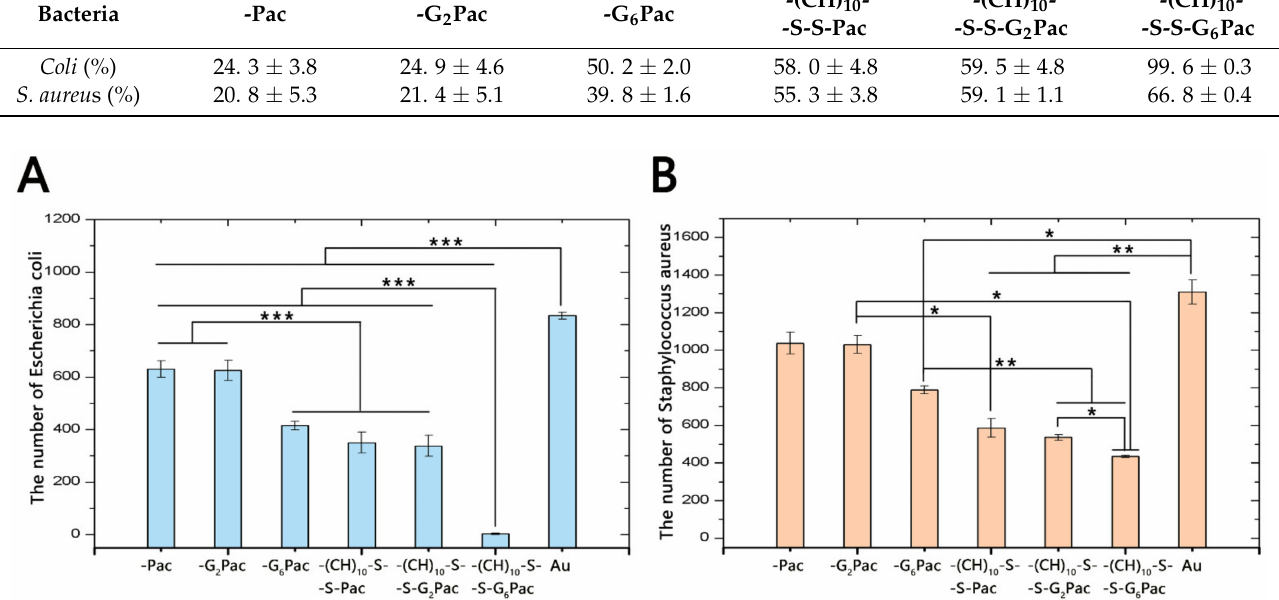
Figure 4. The antibacterial ability of the AMP-functionalized surfaces against E. coli ( A ) and S. aureus ( B ) by bacterial counting (* p < 0.05, ** p < 0.01 and *** p < 0.001).